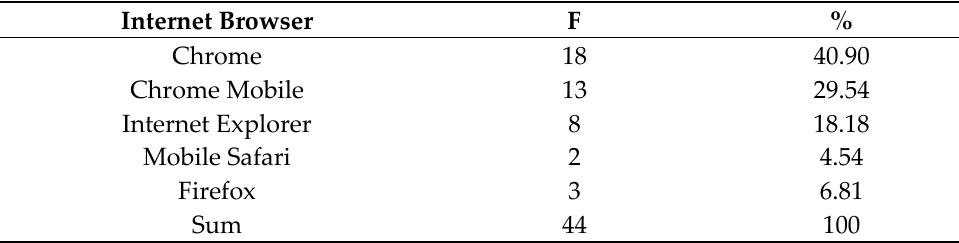
Table 3. Users’ internet browsers.